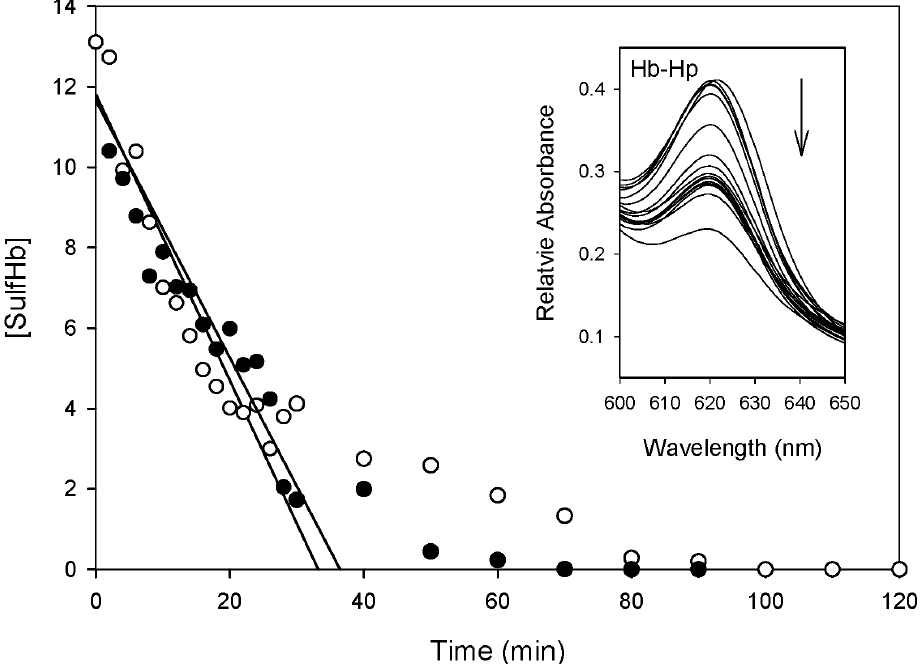
N ) and open ( # ) circles in the graph represent the